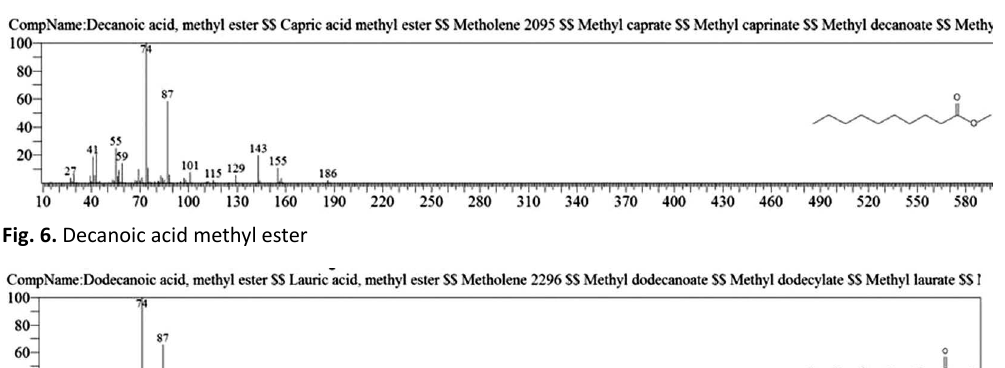
Fig. 5. Methyl tetradecanoate